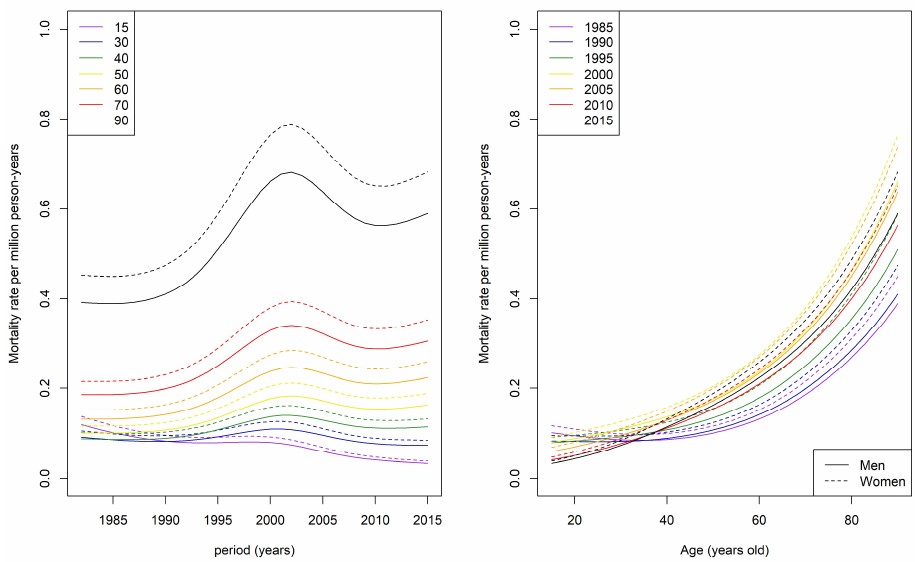
Figure 3. Predicted mortality rate per 1 million person-years using the generalized additive model (taking into account sex and year of death, left panel) and predicted mortality rate per 1 million person-years using the generalized additive model (taking into account sex and age at death, right panel).